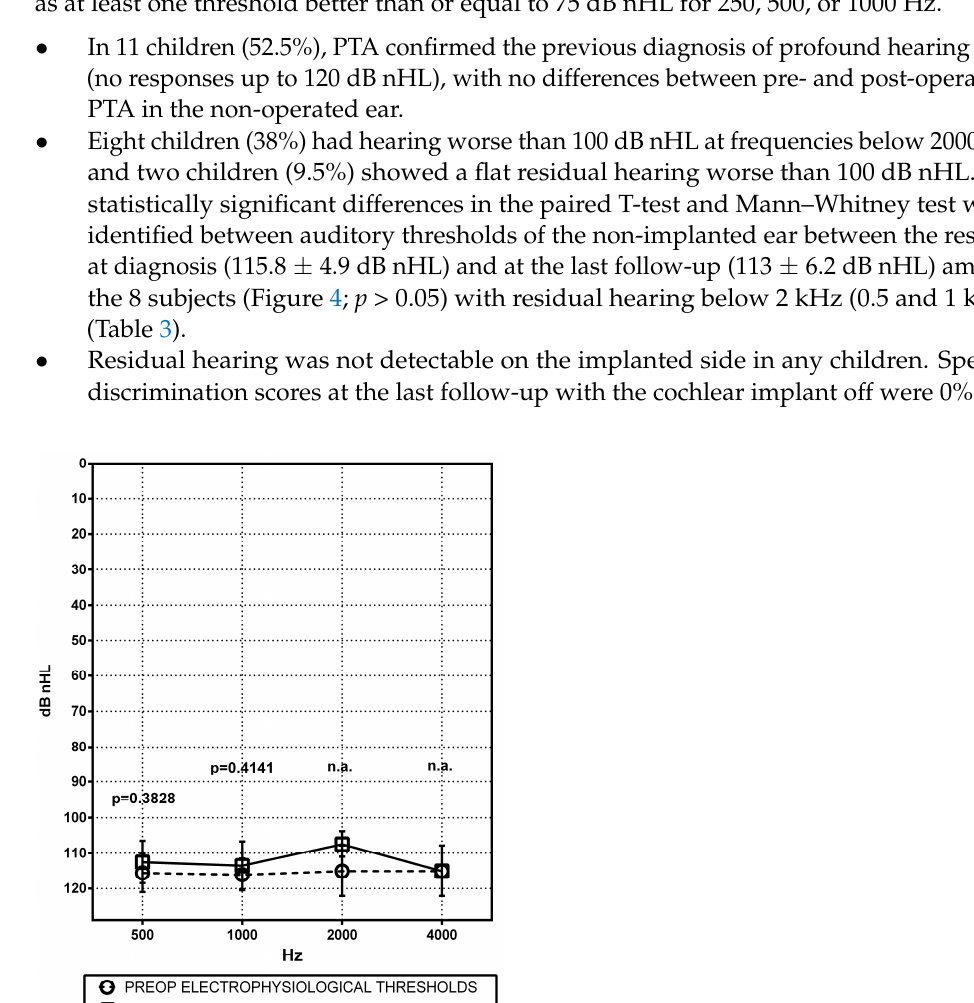
Table 3. Mean hearing threshold at diagnosis and at the last follow-up on the non-implanted side in the 8 subjects with residual hearing below 2 kHz.